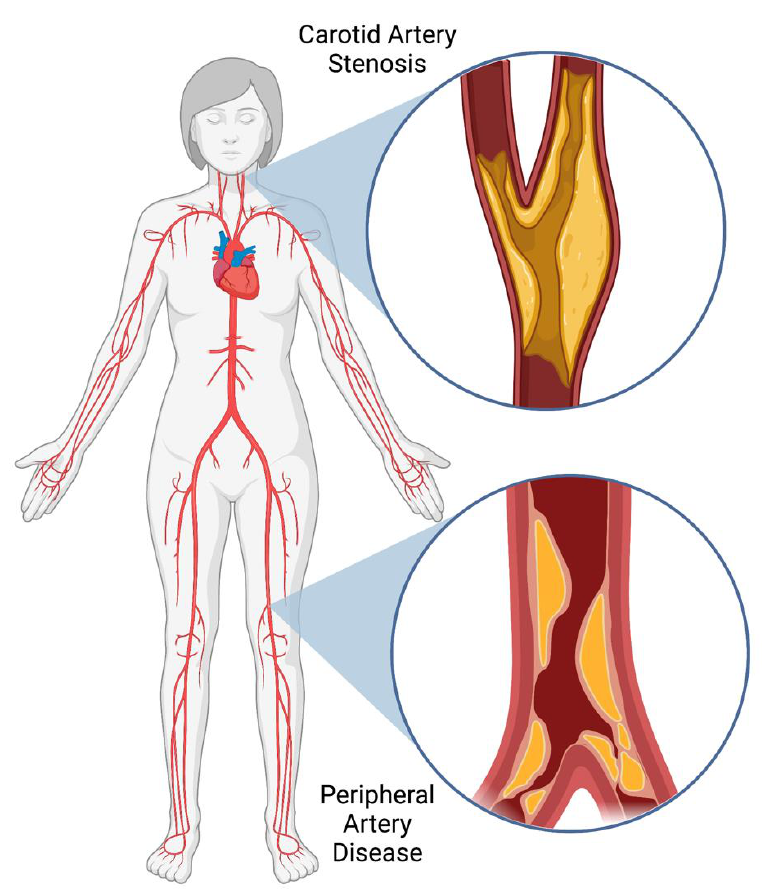
Figure 1. Example of the anatomical locations of atherosclerotic plaque formation other than the coronary vessels such as in carotid artery stenosis (upper diagram), and peripheral arterial disease (lower diagram).